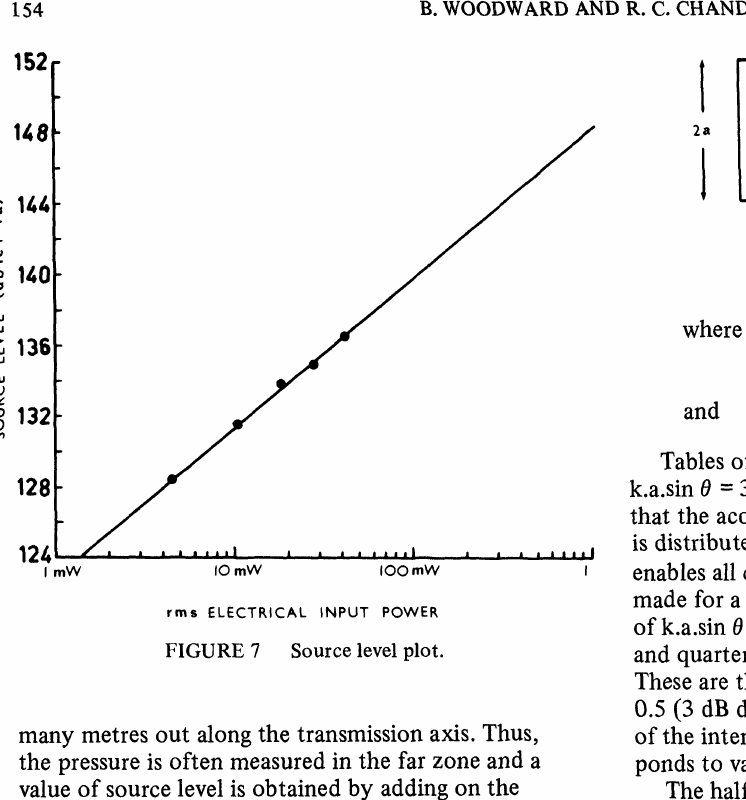
FIGURE 7 Source level plot.